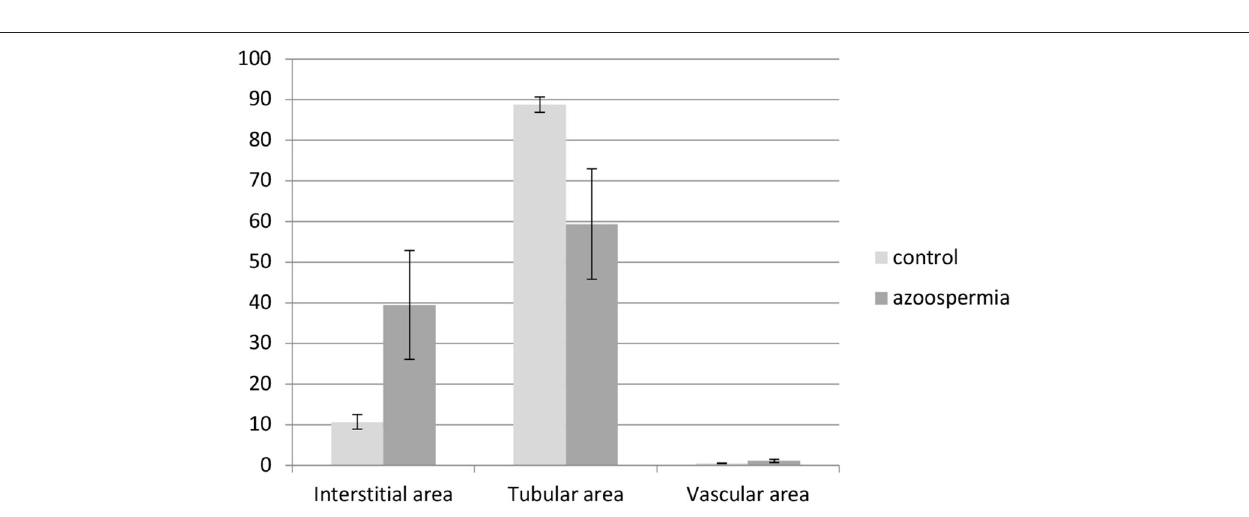
FIGURE 4 | Morphometry of interstitial, tubular, and vascular areas (%) of testicular tissues obtained from azoospermic and normospermic dogs (control). Interstitial and vascular areas are significantly increased ( p < 0.01 and p < 0.0001, respectively), whereas tubular area is significantly decreased in testicular tissues from azoospermic compared with normospermic dogs ( p <